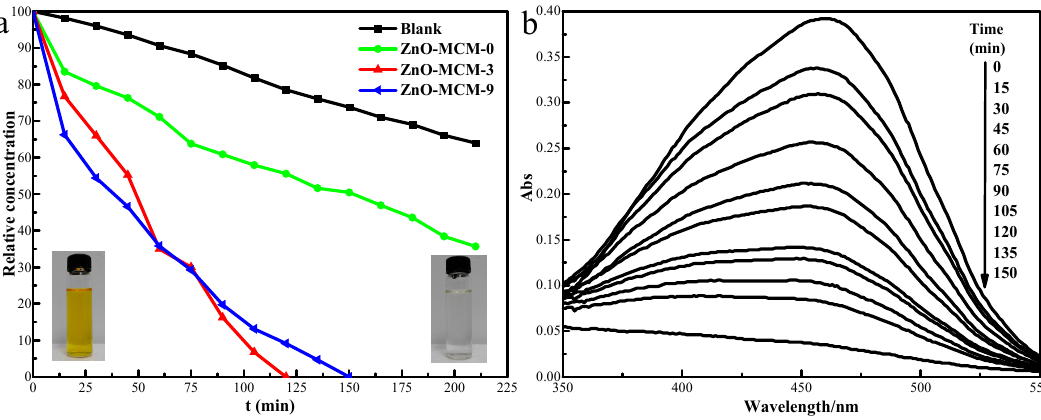
Figure 10. Photodegradation of MO under UV light using ZnO-MCM-0, ZnO-MCM-3 and ZnO-MCM-9 ( a ); and UV-Vis absorbance spectra of MO ( b ).